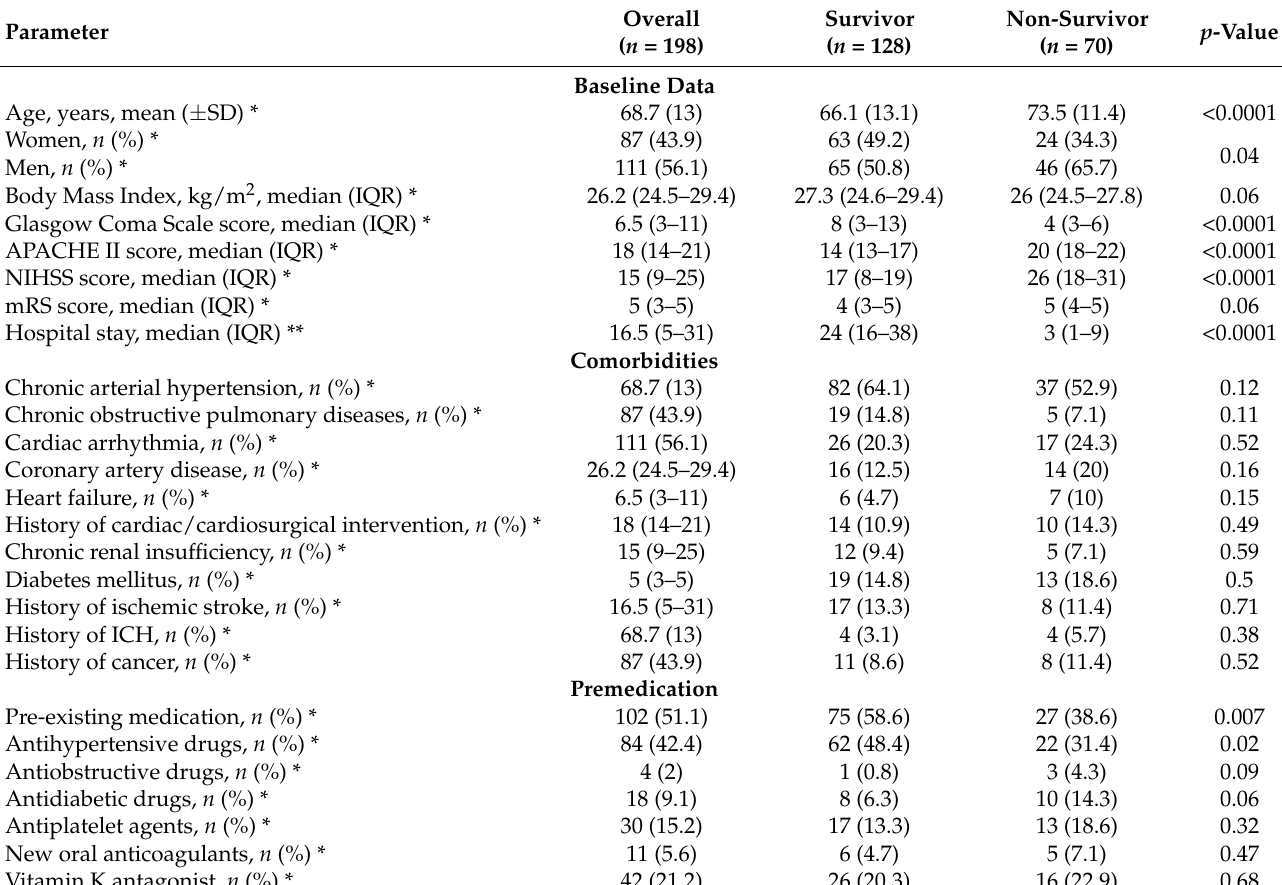
Table 1. Baseline data, comorbidities and premedication of the study population.